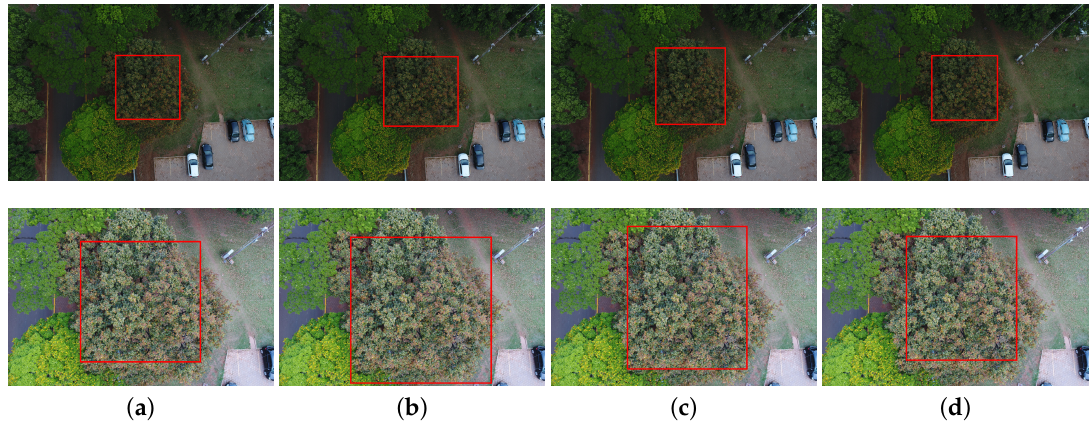
Figure 5. Examples of detection results in images captured for different lighting (average of 67.15 and 130.99 for the brightness channel of the HSB color space) and scale conditions (1:4000 and 1:2500): ( a ) ground truth; ( b ) Faster-RCNN; ( c ) YOLOv3; and ( d ) RetinaNet.